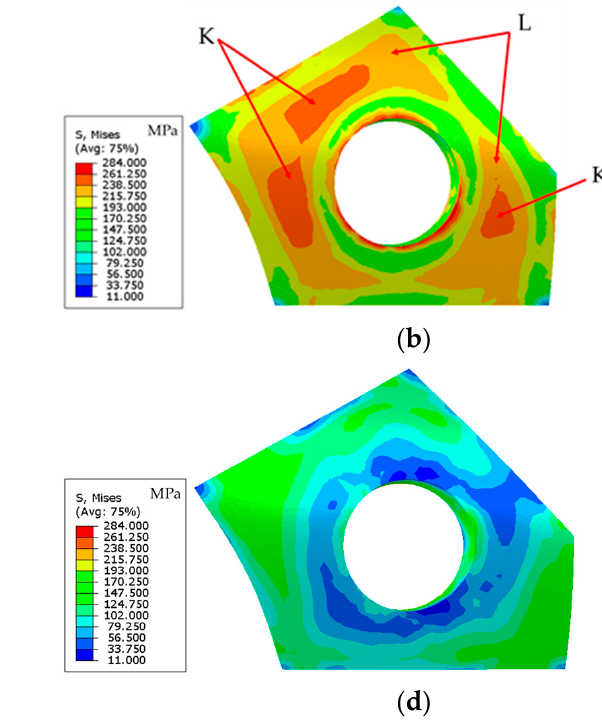
( d ) Figure 6. E ff ect of cold expansion ratio on quenched stress of the forging: ( a ) stress in X-direction; ( b ) stress in Y-direction; ( c ) stress in Z-direction; ( d ) von Mises stress. The most e ff ective ratio (2%) was subsequently used. The stress contour maps of the forging after quenching and cold expansion were shown in Figure 7. The distribution of von Mises stress could be seen in the maps. After quenching, the von Mises stress on the surface of the forging reached 283 MPa, and the von Mises stress in the center thickness of the forging reached 210 MPa. After quenching, the von Mises stress in the K region of the forging surface was above 260 MPa, and the von Mises stress value in the L region was above 220 MPa, in Figure 7b. The K and L regions exhibited large stress, and the sum of the two areas occupied 2/3 of the convex surface. After the cold expansion, the von Mises stress on the surface of the forging was reduced signi fi cantly to below 120 MPa in most areas, as shown in Figure 7d. The von Mises stress in the K and L regions was e ff ectively relieved. After quenching, it was observed that the stress in most areas of the central layer